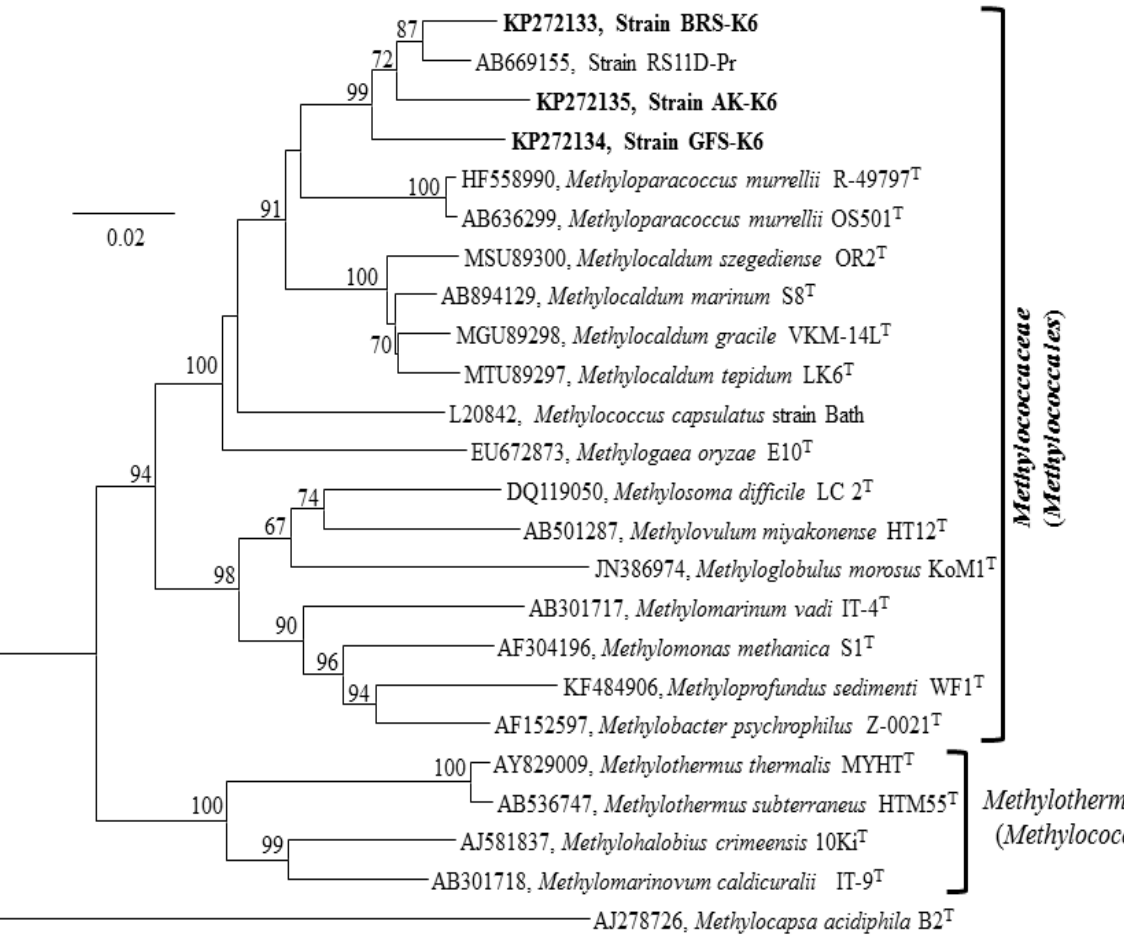
Figure 2. 16S rRNA gene-based neighbour joining tree showing the phylogeny of three isolates, BRS-K6, GFS-K6 and AK-K6 (indicated in bold), relative to other methanotrophic strains of the class Gammaproteobacteria using the MEGA6 software package. Bootstrap values (percentages of 1000 data resamplings) ≥60% are shown at each node. The type II methanotroph Methylocapsa acidophila (AJ278726), of the class Alphaproteobacteria , was used as an outgroup. GenBank accession numbers are given in front of the name of respective isolates. The scale bar represents 0.02 substitutions per nucleotide